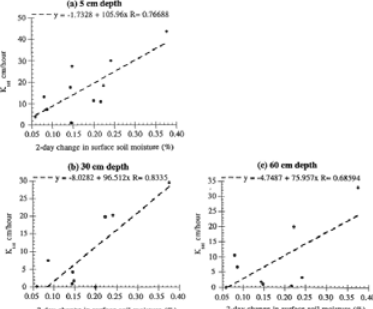
Fig. 9: Relationships between profile harmonic-mean Ksat derived from hydrologic model simulations and two-day initial changes in surface soil moisture obtainable from microwave remote sensing (Mattikali and Engman, 1997).